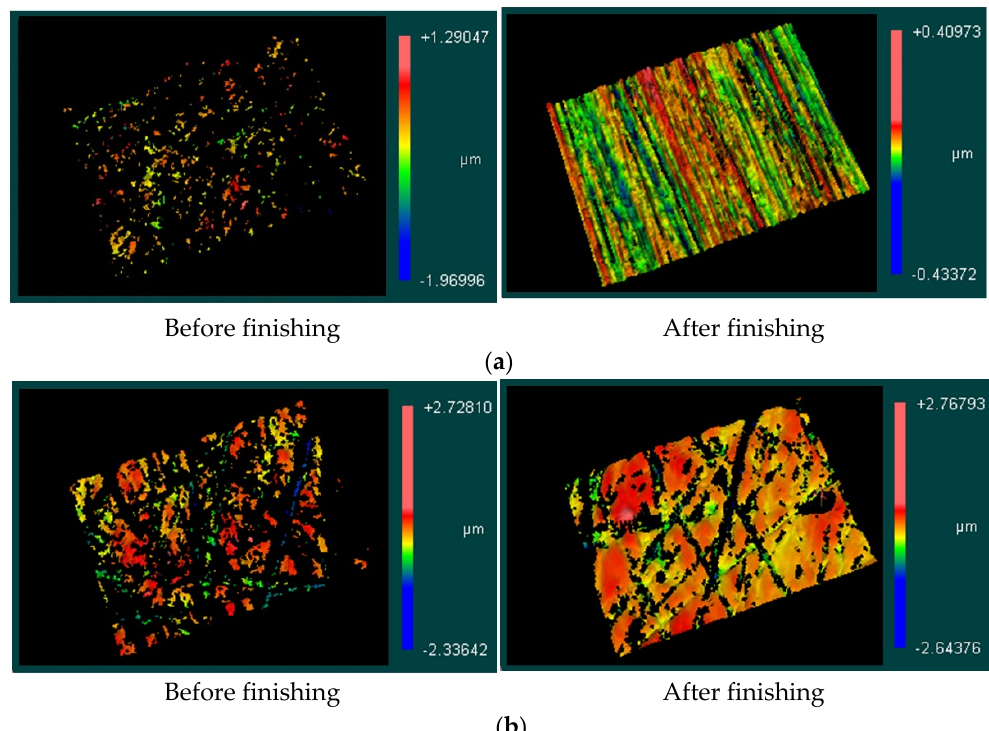
Figure 13. 3D surface morphology before and after finishing with different iron powder size. ( a ) Electrolytic iron powder of 30 µm in mean diameter; ( b ) Carbonyl iron powder, 3.4–4.5 µm in mean diameter.